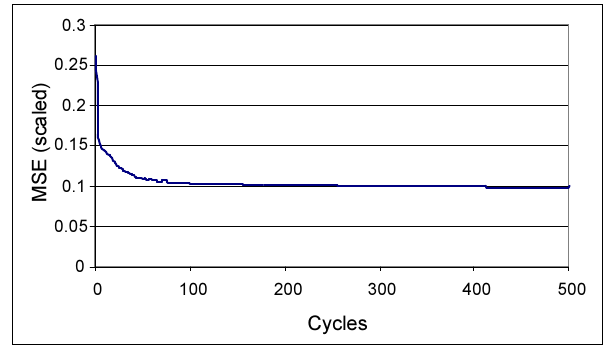
Fig. 5. Training curve for 11-15-15-3 network